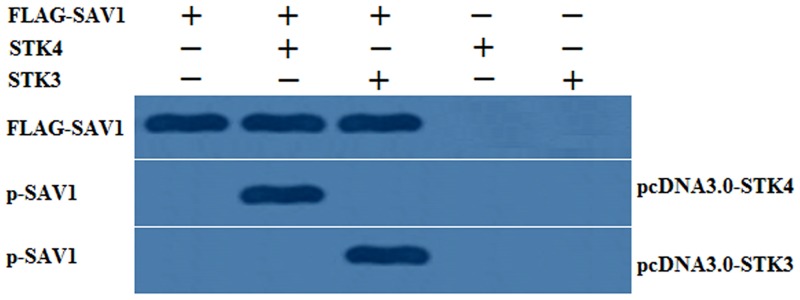
Phosphorylation of SAV1 by SKT3 and SKT4 in vitro.CHO cells (which do not express endogenous chicken SAV1, STK4 and STK3) was co-transfected with the pFLAG-SAV1 expression construct or an empty pFLAG-CMV-2 vector, and the pcDNA3-STK4 or STK3 expression vector or a vacant pcDNA3 vector for 24 h. The cells were lysated and analysed by immunoblotting procedure using an antibody to SAV1 and phosphorylated SAV1 (p-SAV1). The bands were observed corresponding to the antibody of p-SAV1 in the presence of STK4 or STK3 in the cell lysates, but no band was detected for the same lysates in the absence of STK4 or STK3.